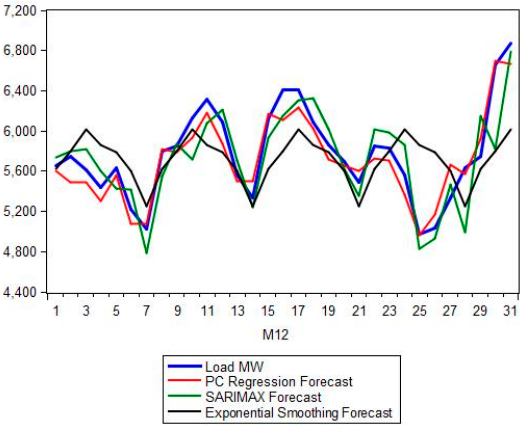
Figure 22. Forecast accuracy comparison for December 2014 for the Greek electricity market.